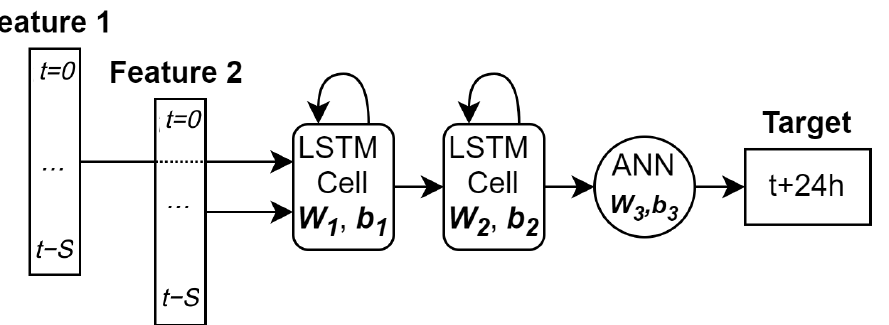
Figure 5. In models with multiple hidden LSTM layers, the LSTM cell is connected to a second LSTM cell, and finally a ANN output layer resulting in a single predicted target at t + 24 h and features as shown. Multiple features are input to the same first hidden layer. The first LSTM layer has a set of weights W 1 and b 1 , whereas the second LSTM layer has different weights, W 2 and b 2 . The LSTM cell output, y = h has the length U . The feature vectors and LSTM cells are tilted 90 ◦ clockwise for